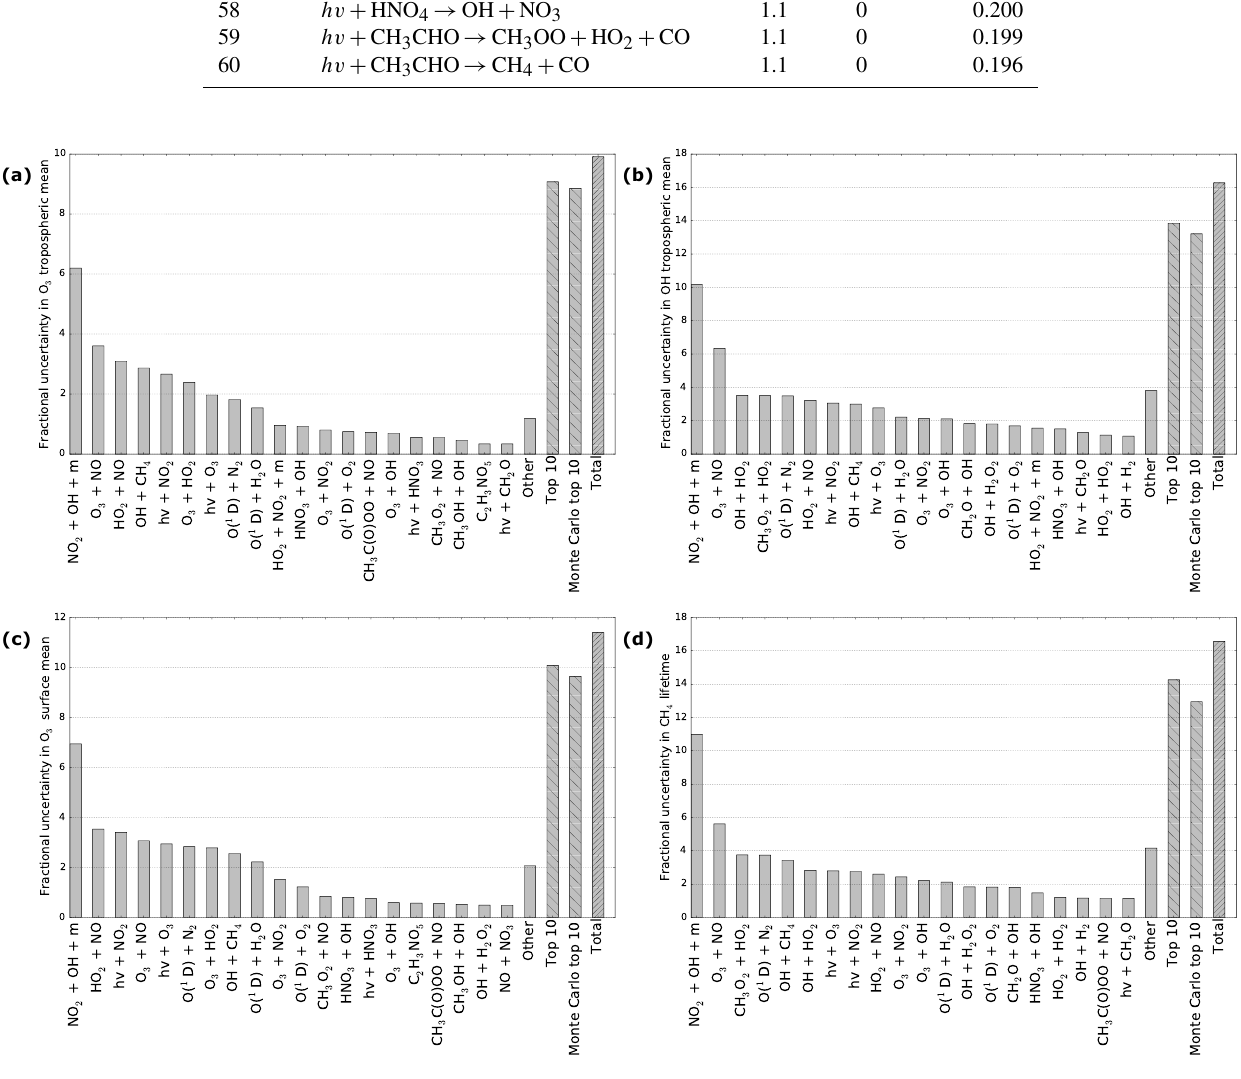
Figure 2. Uncertainties in all metrics: fractional uncertainties of (a) O 3 tropospheric burden, (b) OH tropospheric burden, (c) O 3 surface concentration and (d) CH 4 lifetime. Each bar labelled with a reaction represents a run with a 1 σ increase in the rate constant. “Other” represents the addition in quadrature of the reactions that were not the top 20 most influential. “Top 10” represents the addition in quadrature of the 10 most important reactions, and “Monte Carlo top 10” represents the standard deviation of the Monte Carlo ensemble. “Total” represents the addition in quadrature of all the